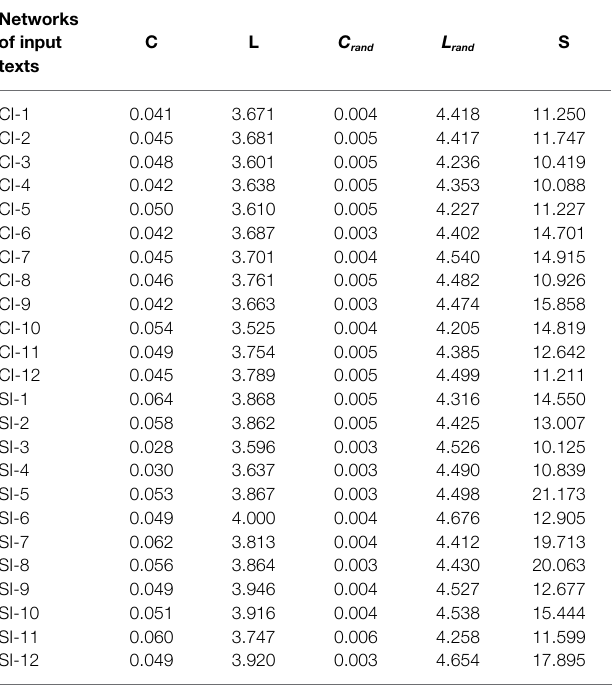
TABLE 3 | Results of key parameters measuring network small-worldness (networks of input texts). Networks of input texts